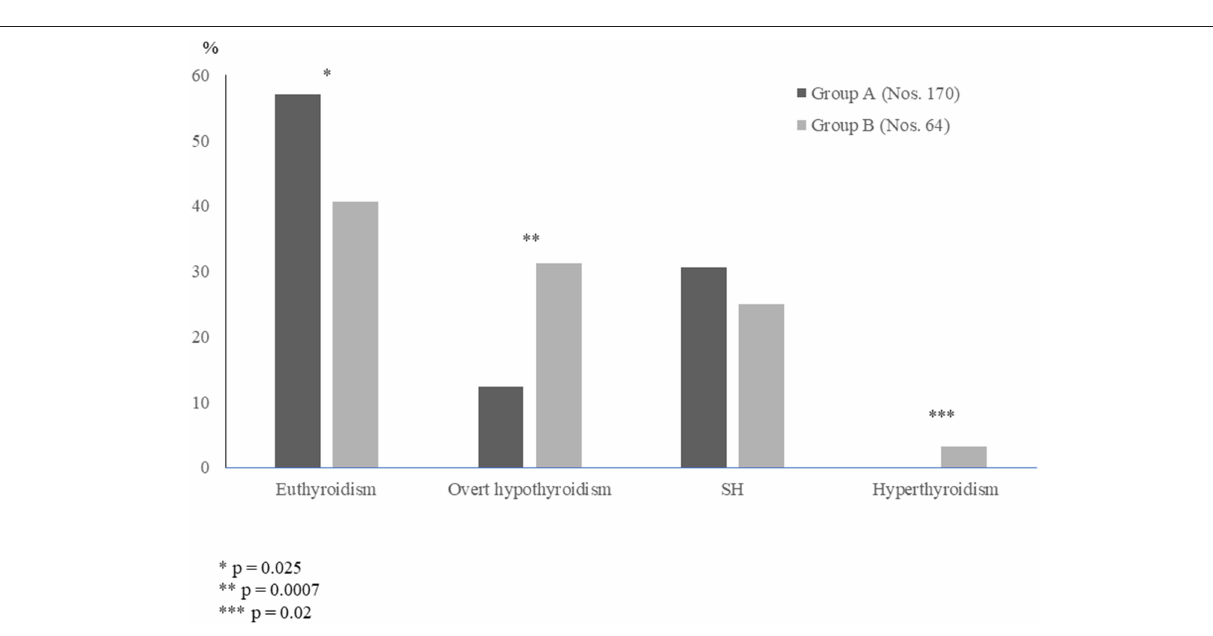
pregnant or who plan pregnancy and in adult patients with TSH persistently above 10 mIU/l (45, 46). In addition, many authors recommend therapy in patients with thyroid enlargement and